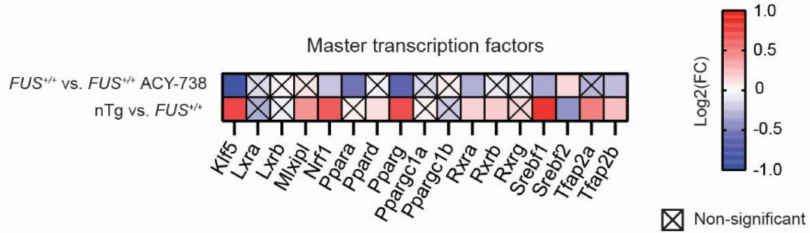
Figure 5. ACY-738 treatment mitigates the activation of master transcription factors involved in lipid metabolism. Heatmap showing color-coded differential expression of significantly down- (blue) or upregulated (red) genes involved in lipid metabolism in the spinal cord of 60-day-old mice. Data are represented as log2 fold change (FC). Crossed squares represent non-significant comparisons. Statistical significance was calculated by 1-way ANOVA. Only genes with a p > 0.05, FDR adjusted, were considered as significantly dysregulated. n = 6 per